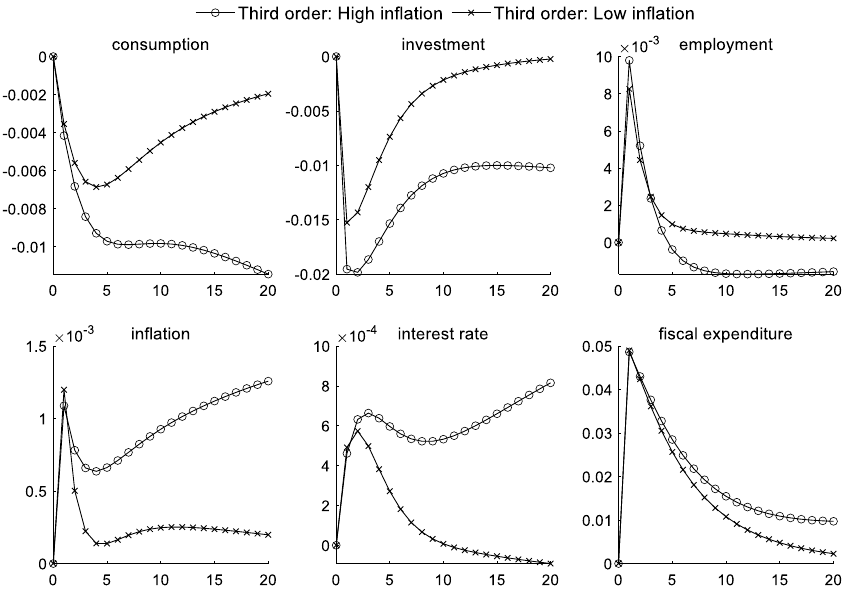
Fig. 4 Impact of uncertainty risk on fiscal policy shocks under different inflation